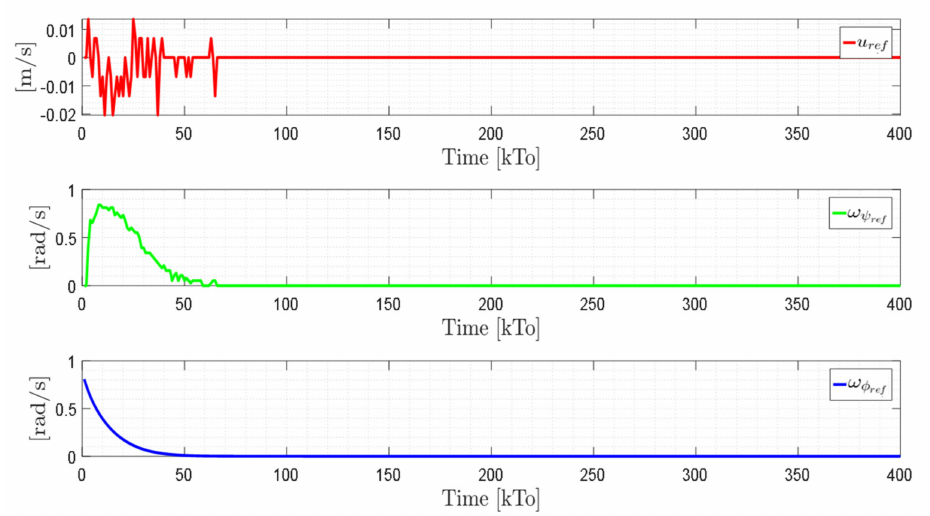
Figure 19. Velocity commands to the standing wheelchair µ ref ( kT 0 ) = ( µ x , ω ψ Control errors (cid:101) η x and (cid:101) η y do not tend to zero, because these control states are not